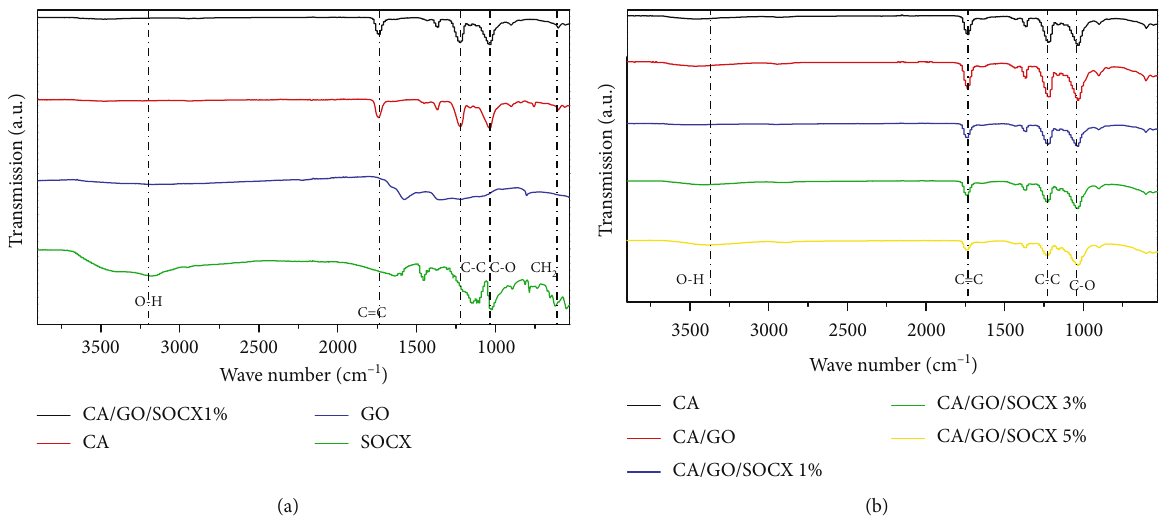
Figure 2: Schematic diagram of the nano fi ber preparation using electrospinning setup.